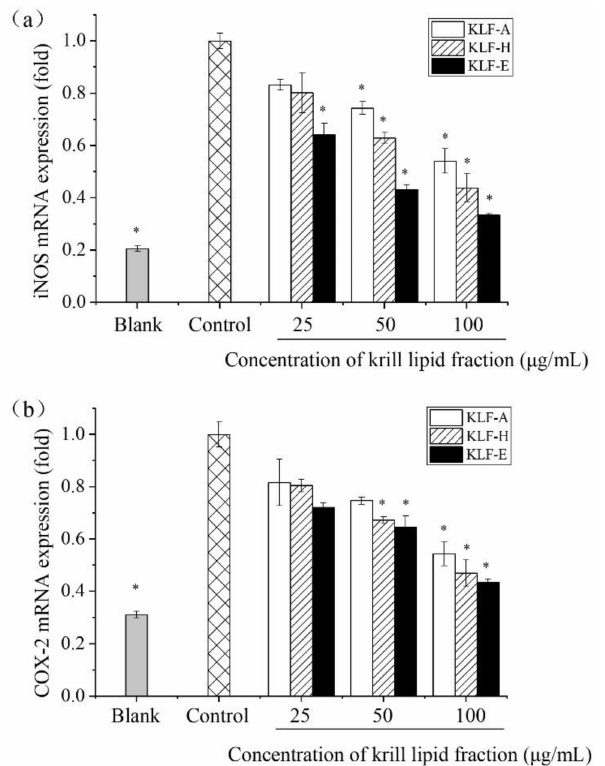
Figure 5. Effect of three krill lipid fractions on mRNA expression of inducible enzymes ( a ) iNOS and ( b ) COX-2 in RAW264.7 cells with LPS stimulation. Blank group referred to the untreated cells; cells treated with LPS alone were considered as the control group. * p < 0.05 versus the control group; one-way analysis of variance (ANOVA) combined with the Games–Howell test was used to analyze the significance. Abbreviations: LPS, lipopolysaccharide; KLF-A, the krill lipid fraction extracted with acetone in the first step; KLF-H, the krill lipid fraction extracted with hexane in the second step; KLF-E, the krill lipid fraction extracted with ethanol in the third